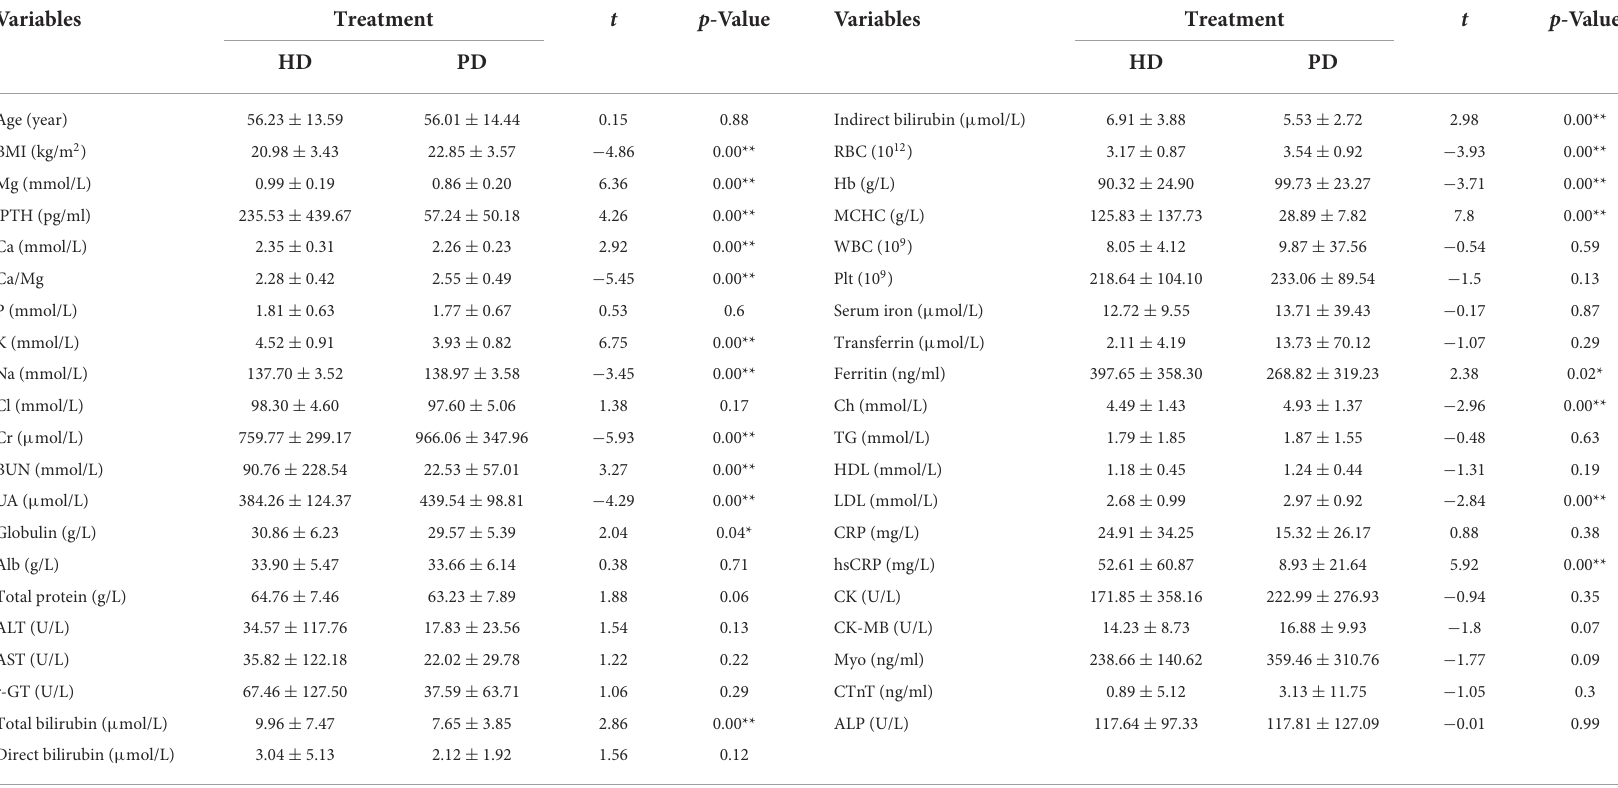
TABLE 2 Results of t -test